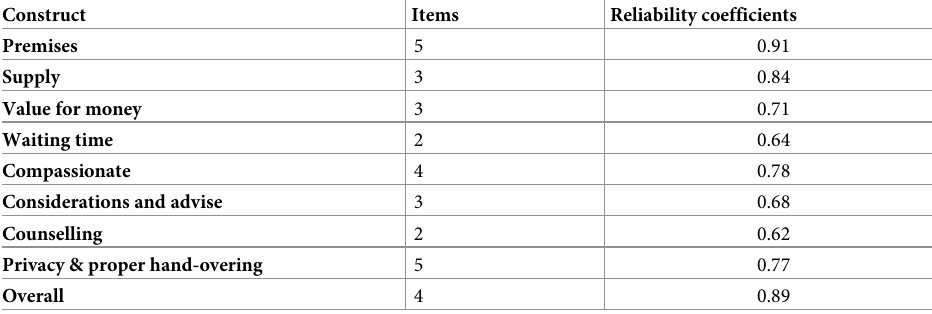
Table 3. Cronbach’s Alpha (reliability coefficient) for each construct of pharmacy service, December 2020.